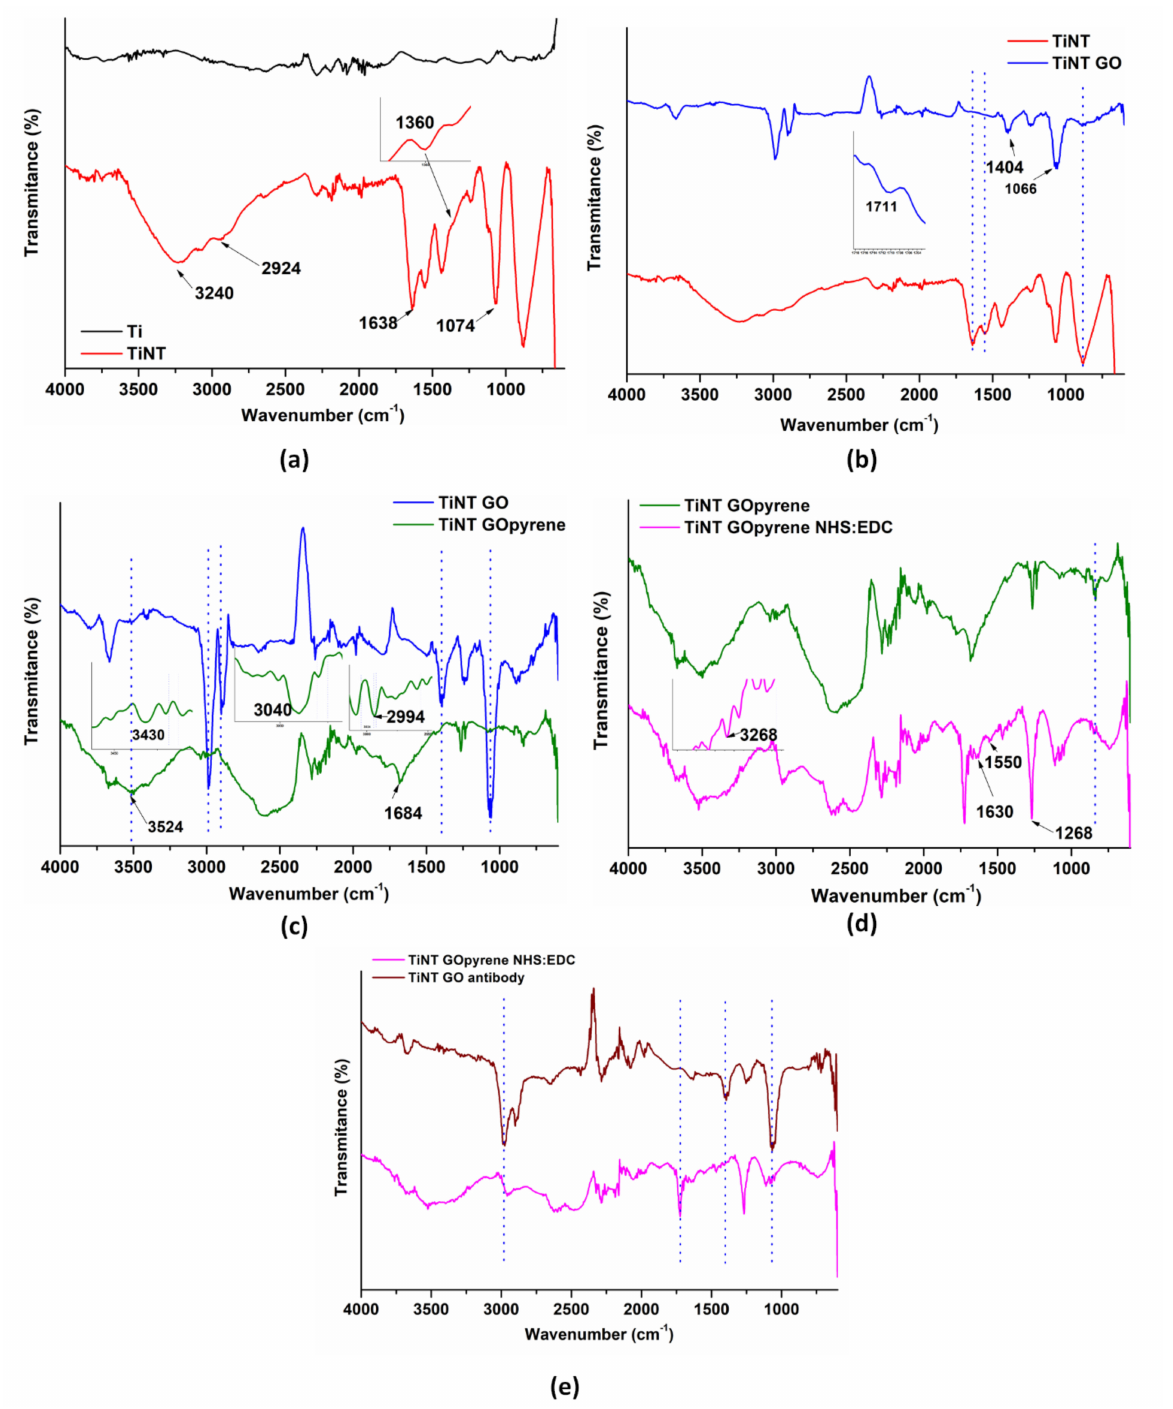
Figure 4. Comparative FT-IR spectra after each modification step: ( a ) Ti and TiNT, ( b ) TiNT and TiNT GO, ( c ) TiNT GO and TiNT GOpyrene, ( d ) TiNT GOpyrene and TiNT GOpyrene NHS:EDC, ( e ) TiNT GOpyrene NHS:EDC and TiNT GO antibody. For the TiNT sample (Figure 4a, red line), C-O-C bond and CH 2 groups at 1360 cm − 1 (in inset) and respective at 2924 cm − 1 are present, peak at 1638 cm − 1 correspond to coordinated H 2 O as well as Ti-OH, and C-C stretching appears at 1074 cm − 1 [27]. Traces of organic electrolyte